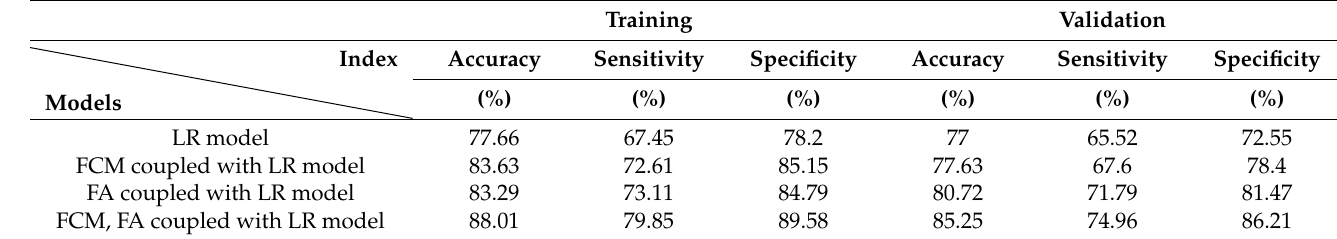
Table 13. Model performance using validation